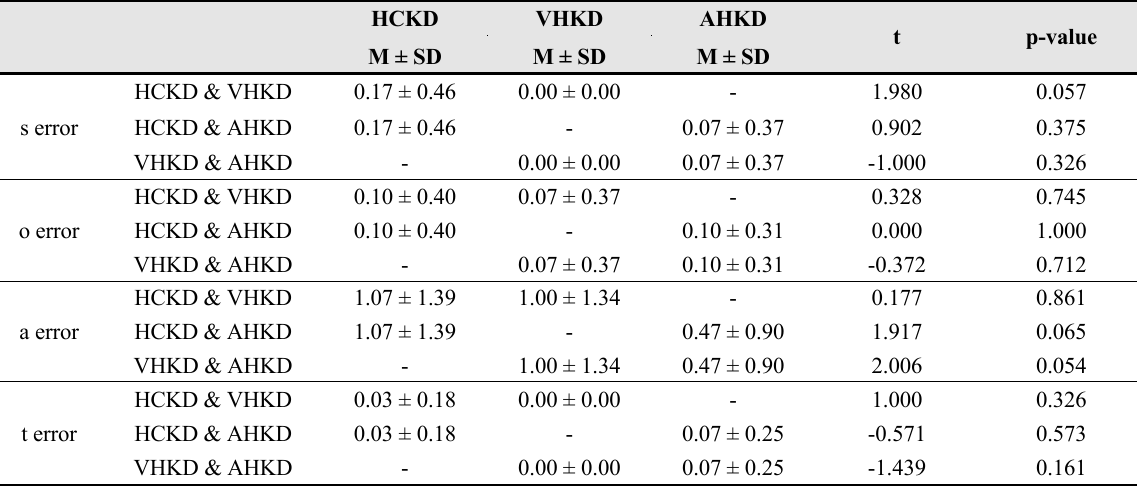
Frequency of error occurrence in Test 1